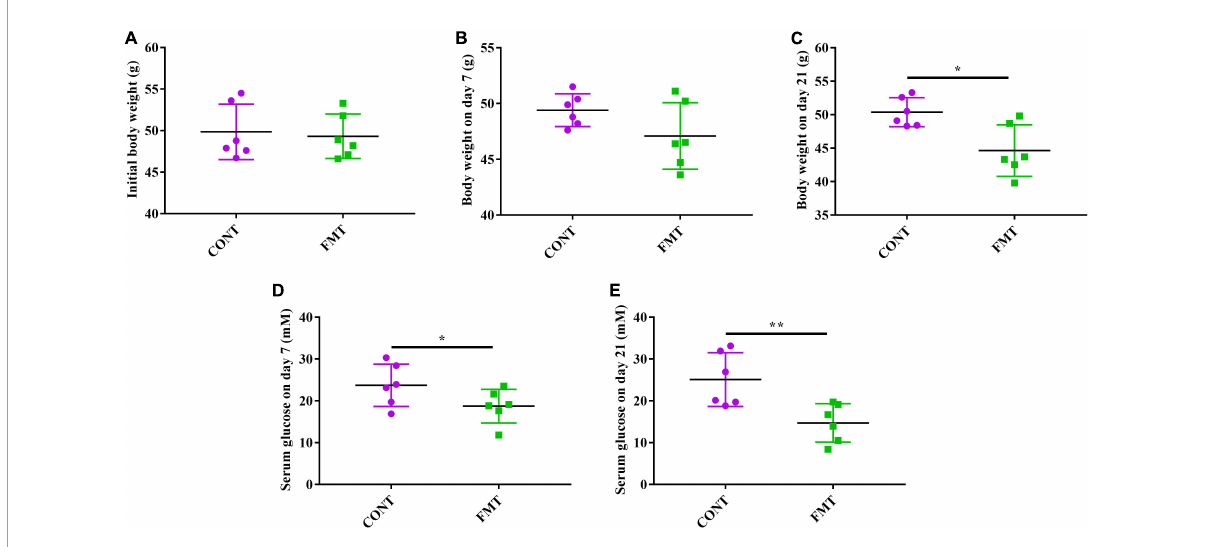
FIGURE6 FMT decreased body weight and glucose level in db/db diabetic mice. (A) Initial body weight; (B) body weight on day 7; (C) Body weight on day 21; (D) serum glucose level on day 7; (E) serum glucose level on day 21. Values are expressed as mean ± SEM, n = 6. * P < 0.05, ** P <